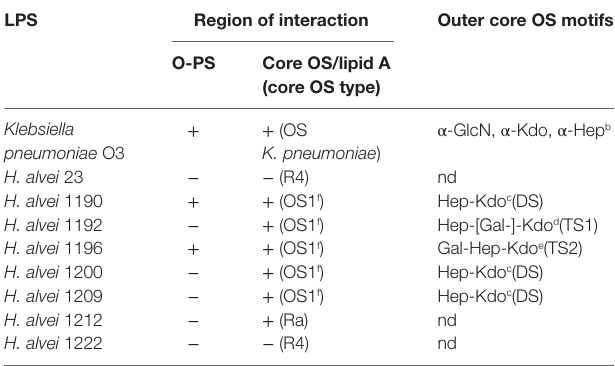
TaBle 1 | Structural characteristics of LPS and lectin blotting results of SDS- PAGE separated Hafnia alvei LPS with serum-derived hMBL.